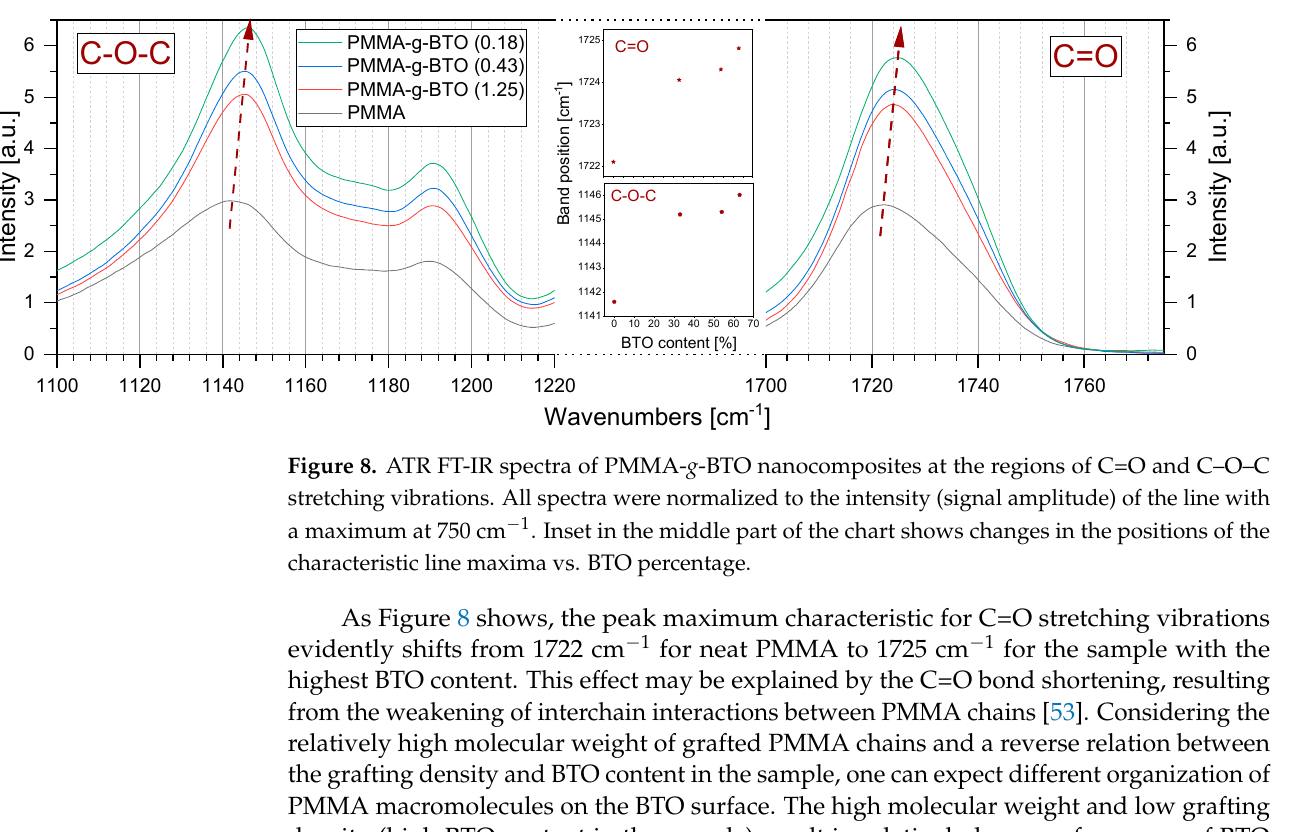
Figure 8. ATR FT-IR spectra of PMMA- g -BTO nanocomposites at the regions of C=O and C–O–C stretching vibrations. All spectra were normalized to the intensity (signal amplitude) of the line with a maximum at 750 cm − 1 . Inset in the middle part of the chart shows changes in the positions of the characteristic line maxima vs. BTO percentage.